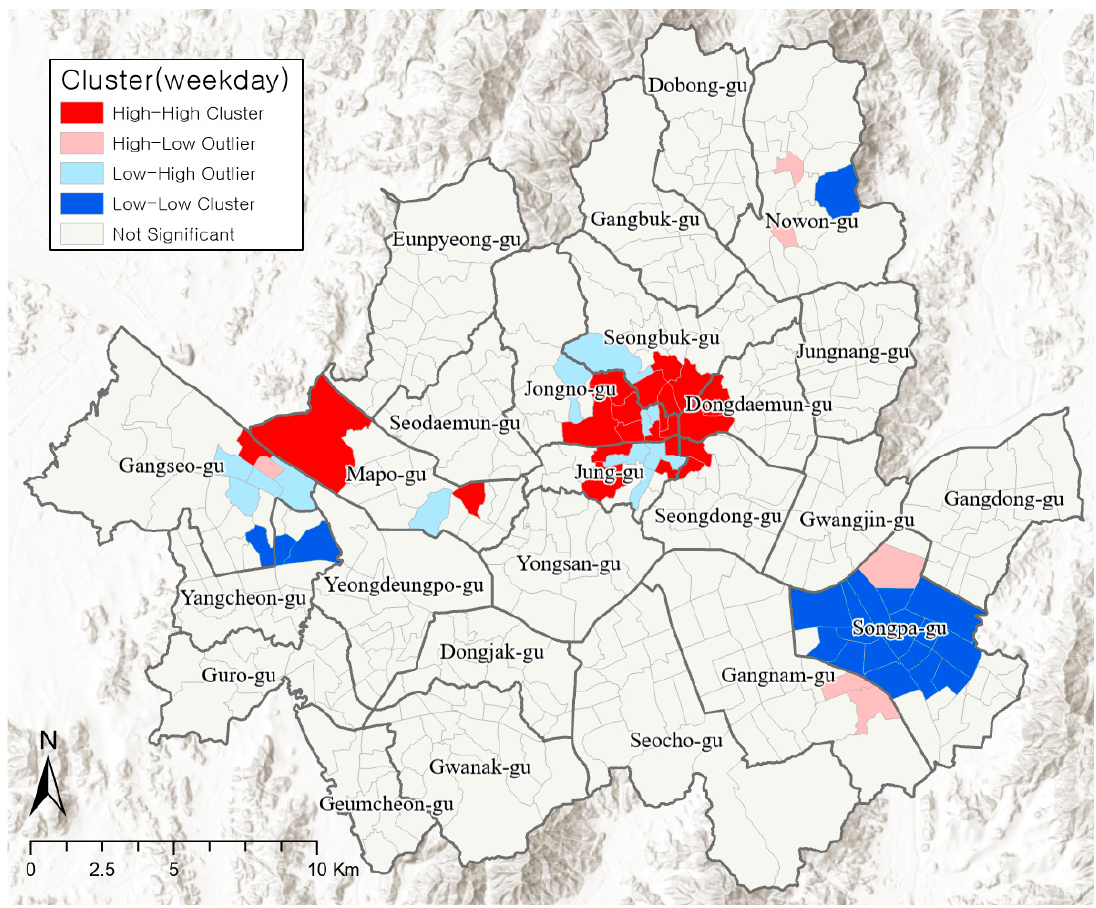
Figure 3. Clusters of visiting population changes on weekdays.